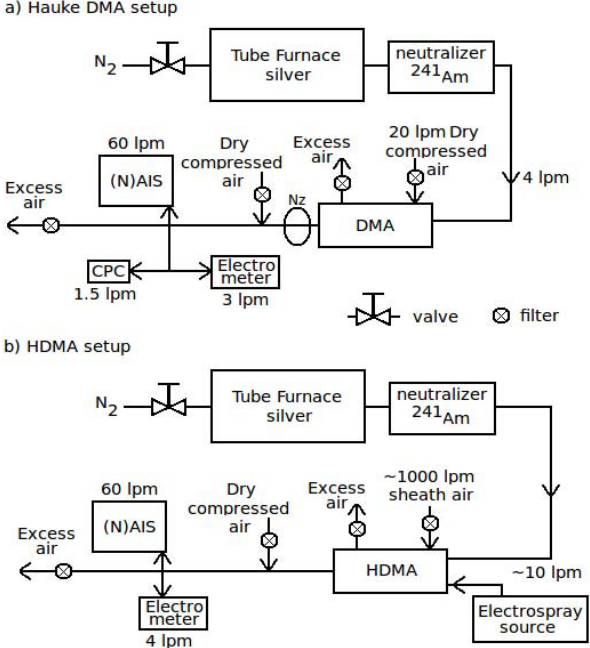
Fig. 2. Schematic figure of the setups used during the calibration procedure. The instruments and the most important flows are in- cluded for (a) Hauke setup, and (b) HDMA setup. The Hauke-setup includes a neutralizer (Nz) for calibrations in particle measurement mode. The HDMA setup can be operated either with the furnace or the electrospray, not both at the same